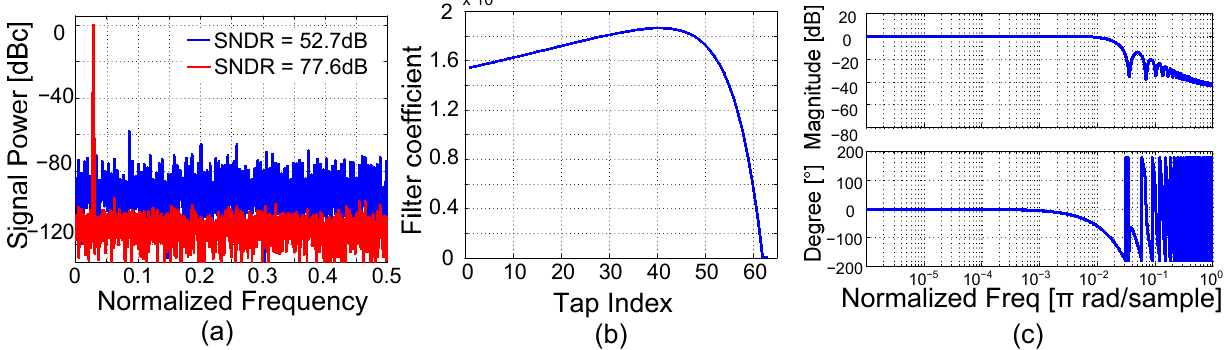
Figure 11. ( a ) Simulated output spectrum with the optimal filter (red) and the CoI filter (blue) when OSR = 65, ( b ) normalized coefficients of the filter, and ( c ) the magnitude and phase response of the filter.